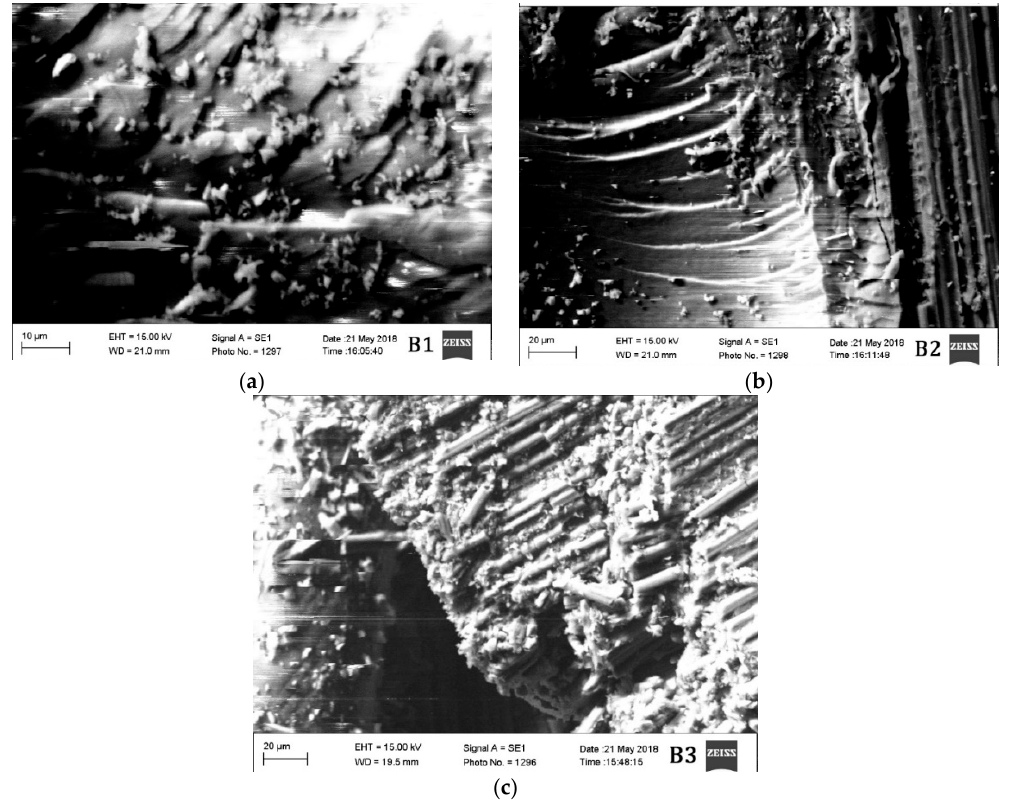
Figure 7. SEM images of materials ( a ) B1, ( b ) B2, and ( c ) B3.